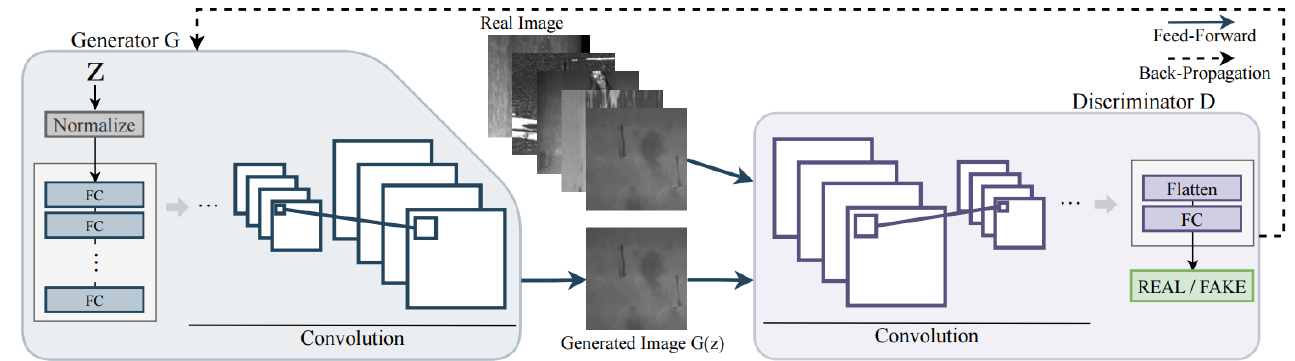
Figure 4. Latent mapping adversarial network framework for defect synthesis [6].